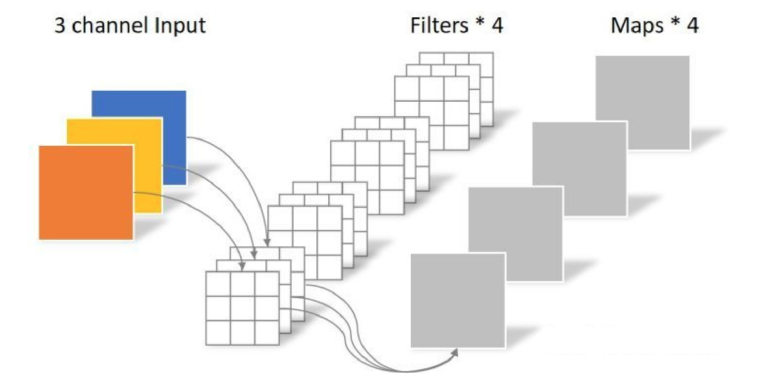
Figure 1. Convolution process illustration.